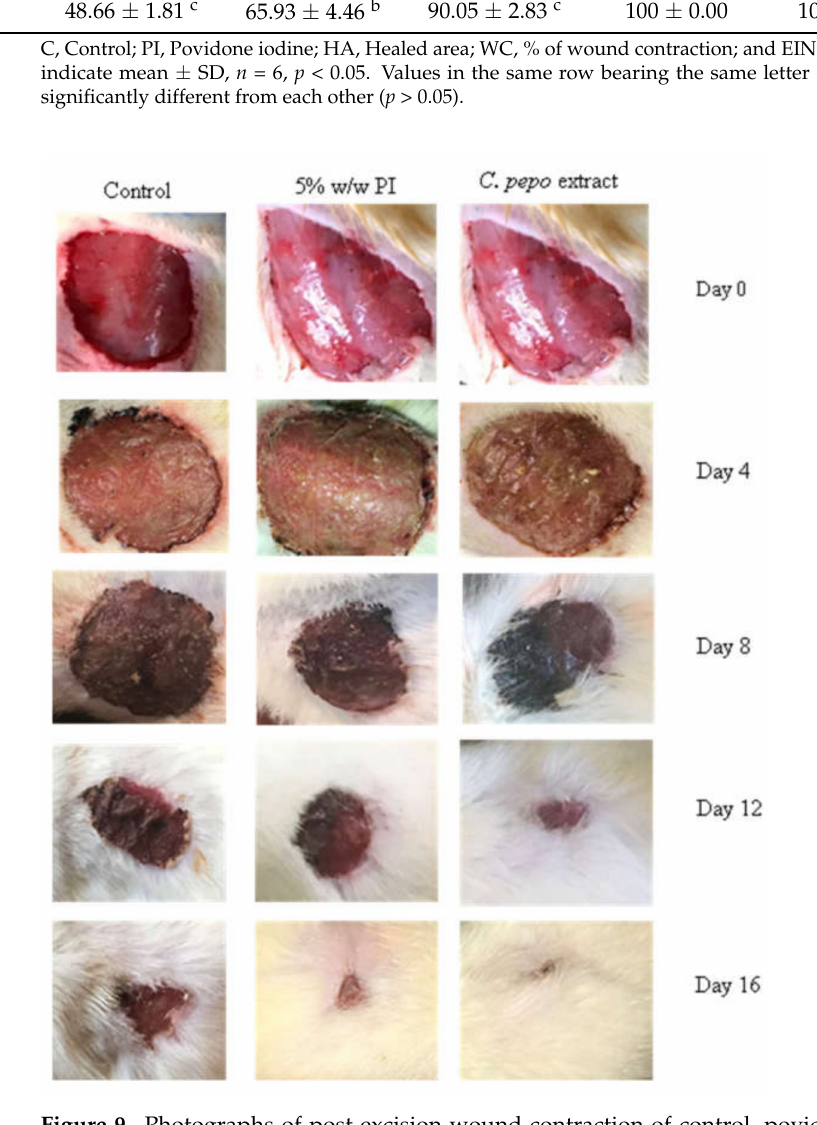
Figure 9. Photographs of post-excision wound contraction of control, povidone (PI) iodine and C. pepo extract treated